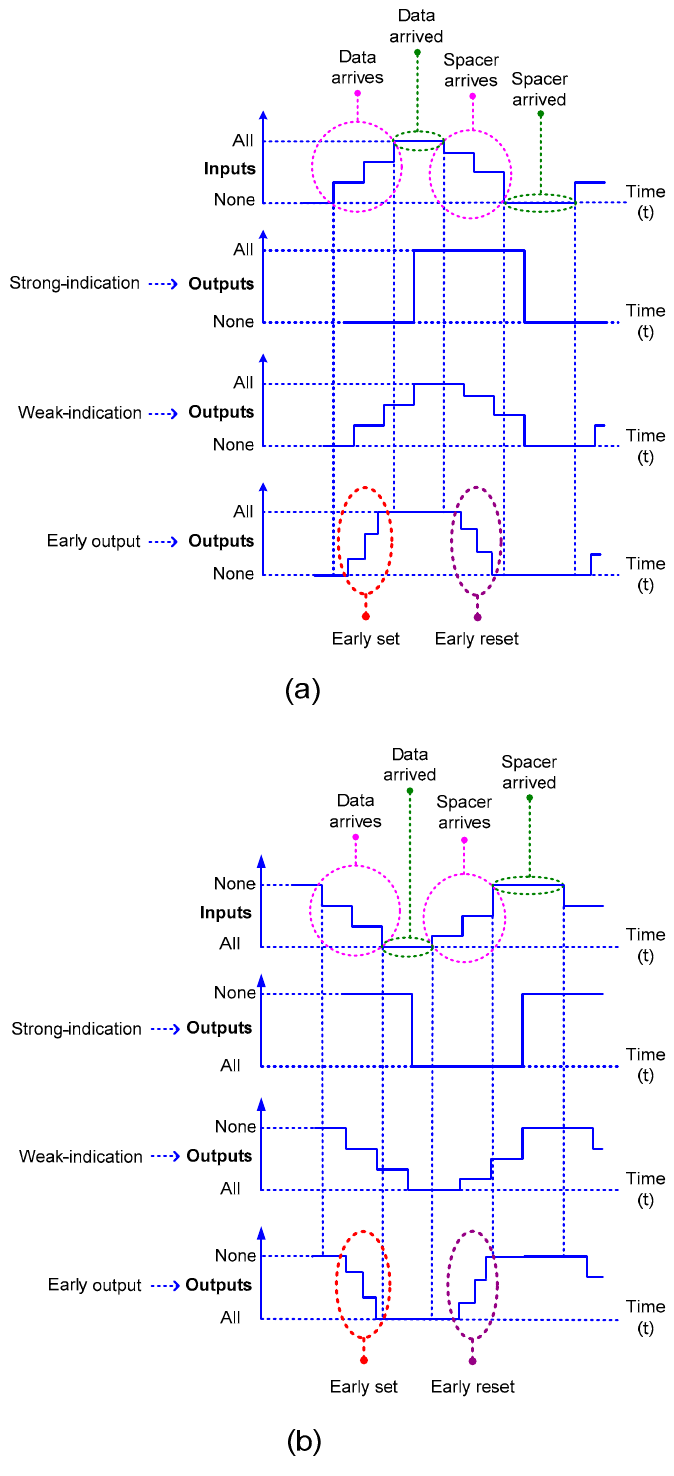
Figure 2. Input–output timing dependency of strong-indication, weak-indication and early output circuits corresponding to: ( a ) RTZ handshaking, and ( b ) RTO handshaking.